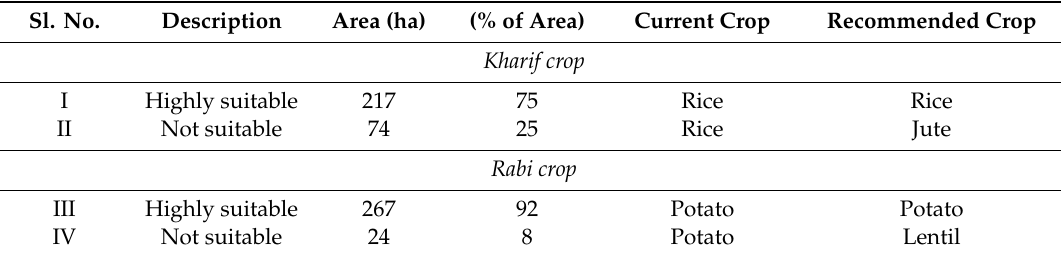
Table 10. Crop recommendation based on suitability